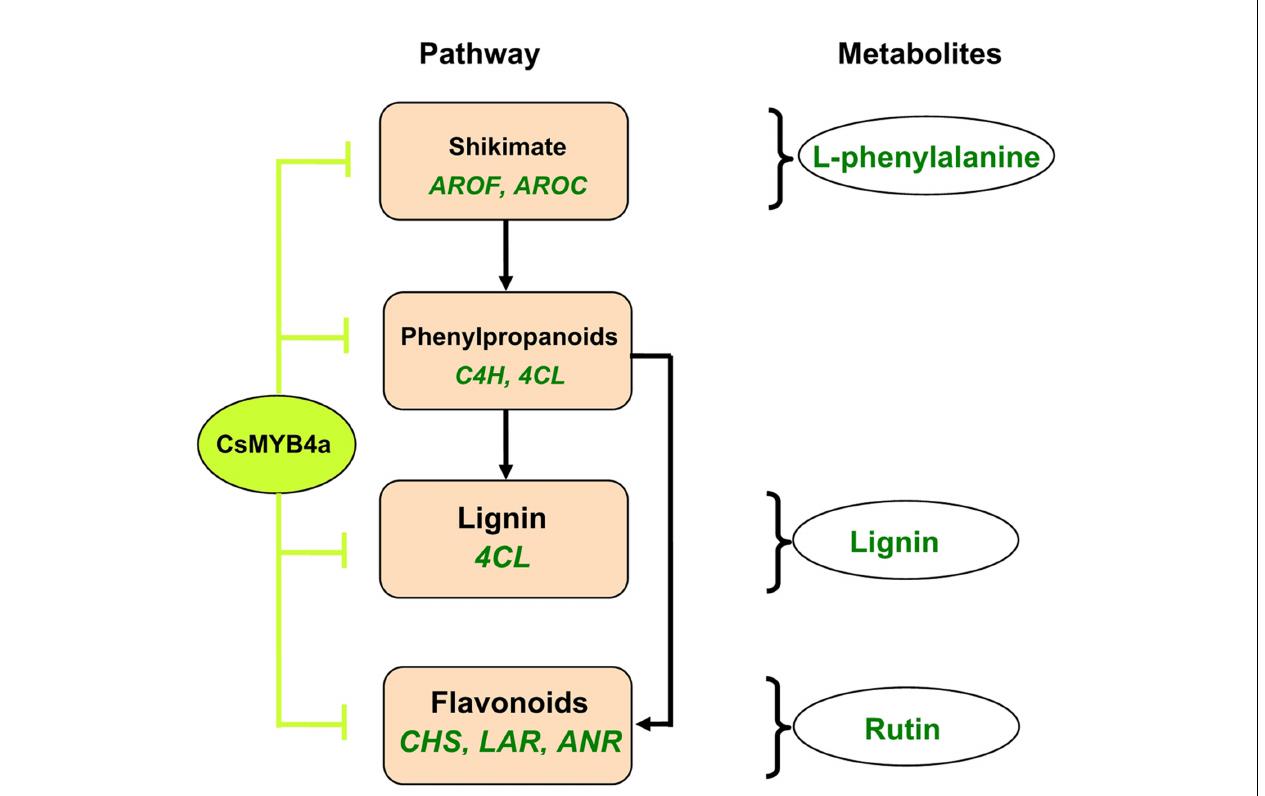
FIGURE 8 | A simplified scheme showing repressive effects of the CsMYB4a on the shikimate and phenylpropanoid pathways. CsMYB4a represses promoting activities via targeting promoters of two genes ( AROF and AROC ) in the shikimate pathway and of five genes ( C4H , 4CL , CHS , LAR, and ANR ) in the phenylpropanoid pathway. Its repressive activity leads to reduction of phenylalanine, lignin, and